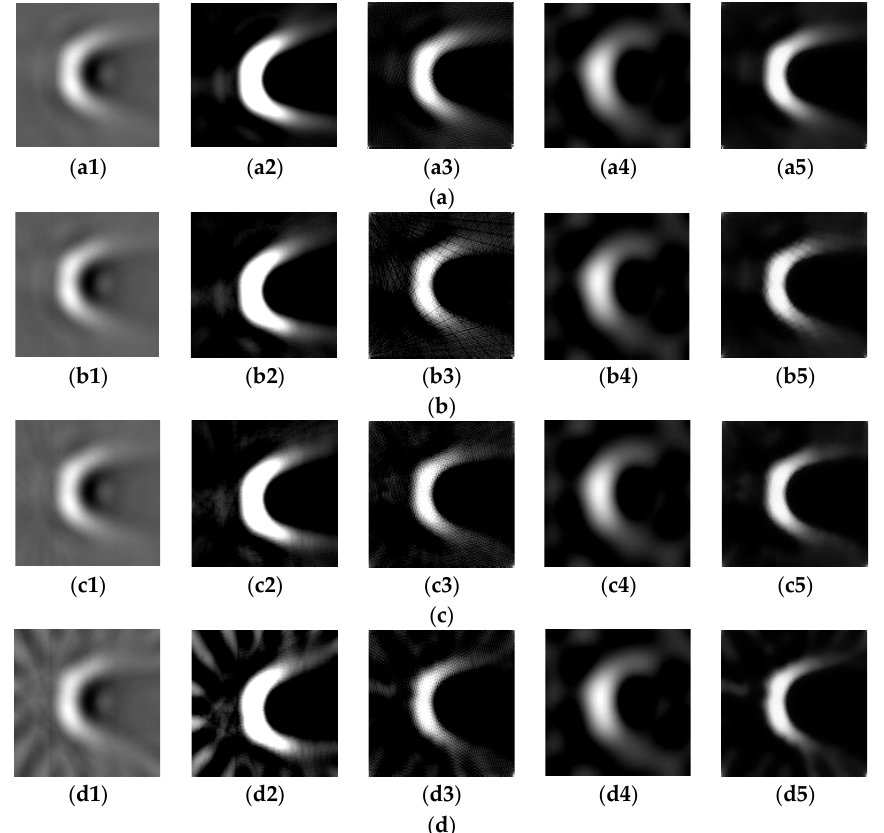
Figure 7. Near-field experimental imaging results with uniformly sampled views of projections ( Far left ) iRadon; ( Left ) FBP; ( Middle ) ART; ( Right ) sparse ART with OMP; ( Far right ) TV sparse reconstruction with ART. ( a ) Complete view data (a1:a5); ( b ) sampled data at 5° intervals (b1:b5); ( c ) sampled data at 10° intervals (c1:c5); ( d ) sampled data at 20° intervals (d1:d5).